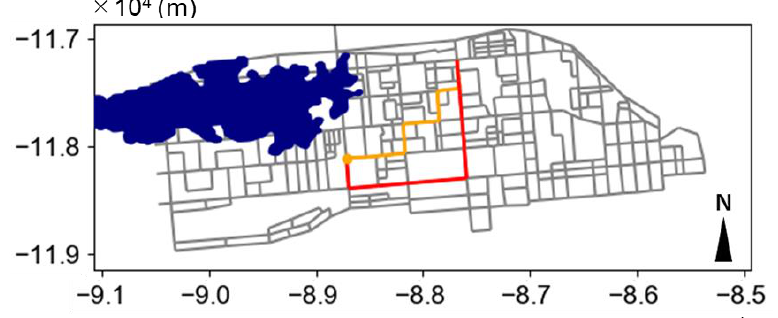
Figure 6. Example of evacuation route by Model I (convention model, yellow line) and Model II (proposed model, red line). Blue shows the inundation area at the start of the evacuation. The x- and y-axes indicate the axis in the Japan Plane Rectangular Coordinate System Xll.